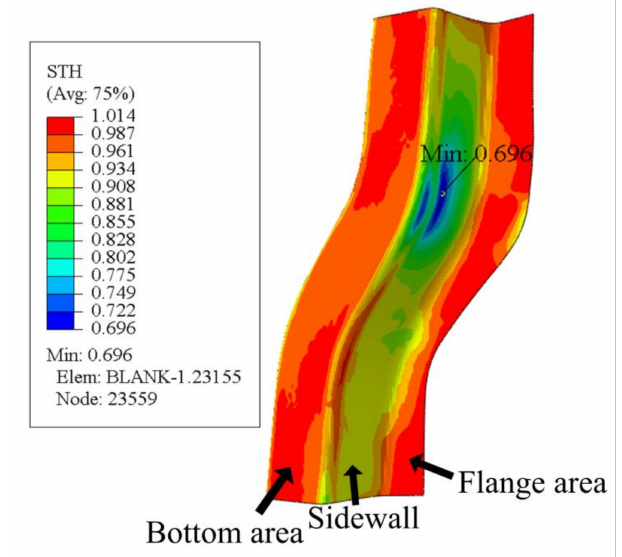
Figure 15. Thickness cloud map at stamping speed of 10 mm/s, friction coefficient of 0.1, and blank holder force of 10.5 kN, forming temperature 410 ◦